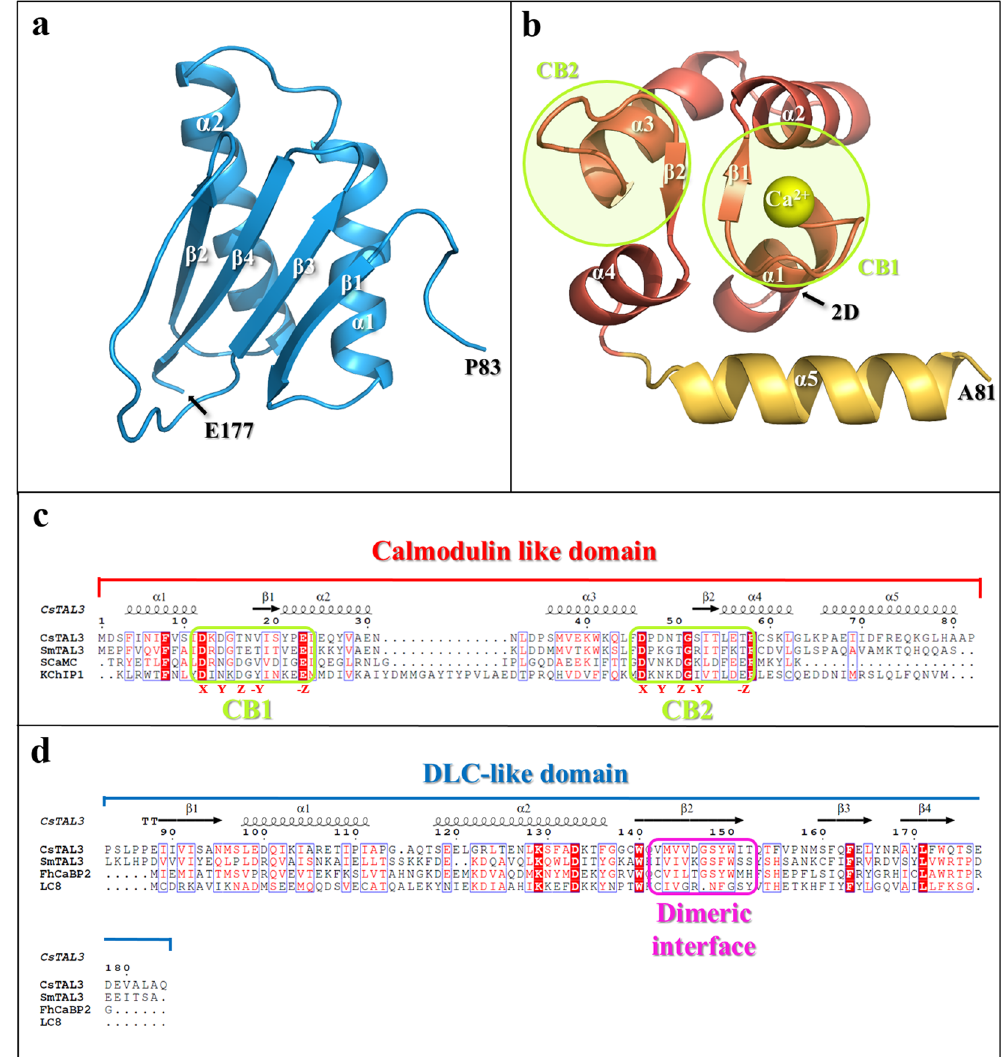
Figure 1. Overall crystal structure of CsTAL3 and sequence alignment. (a) Monomeric structure of the DLC- like domain (aa 83–177). (b) Crystal structure of the calmodulin like domain (aa 2–81). Green circles represent Ca 2 + -binding domains 1 and 2 (CB1 and CB2). (c) Sequence alignment of the calmodulin like domain of CsTAL3 from Clonorchis sinensis (accession code: Q2PMV7), SmTAL3 from Schistosoma mansoni (P91804), SCaMC1 from Homo sapiens (Q6NUK1), and KChIP1 from Homo sapiens (Q9NZI2). CB1 and CB2 residues are boxed in green , and Ca 2 + -binding positions are labeled under each residue. (d) Sequence alignment of the DLC-like domain of CsTAL3, SmTAL3, and FhCaBP2 from Fasciola hepatica (A0A0B5GUS3), and LC8 from Homo sapiens (P63167). Dimeric-interface residues are boxed in magenta